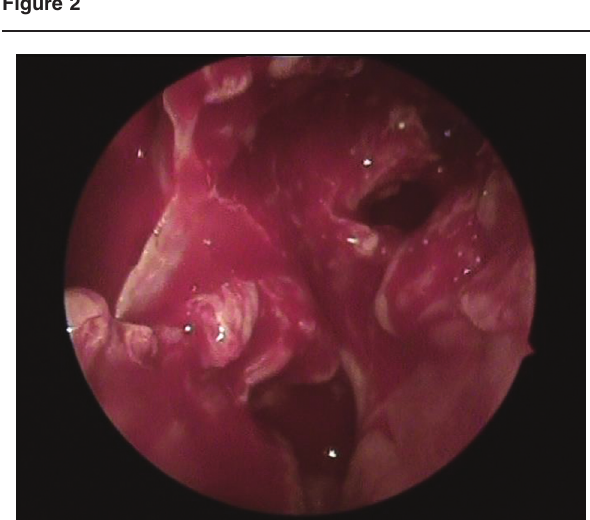
Polyps in middle meatus. Figure 2